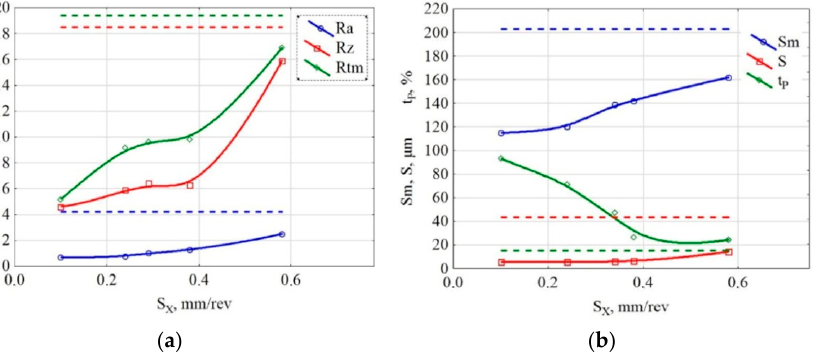
Figure 4. Graph of the change in height Ra, Rz, Rtm ( a ) and stepSm, S, tp ( b ) roughness parameters from the feed Sx of the deforming element (dotted lines indicate the roughness values before ultrasonic treatment) .